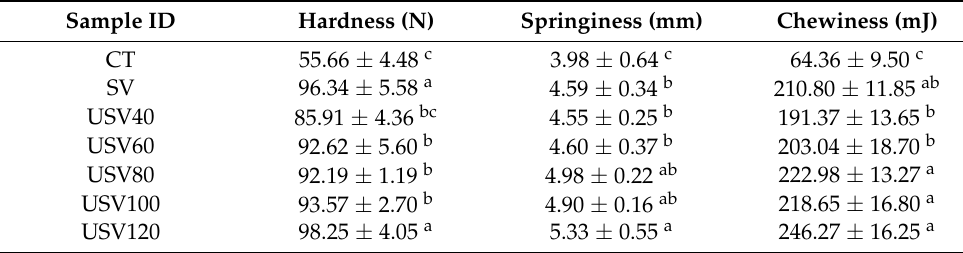
Table 1. Effect of different thermal treatments on the textural properties of spiced